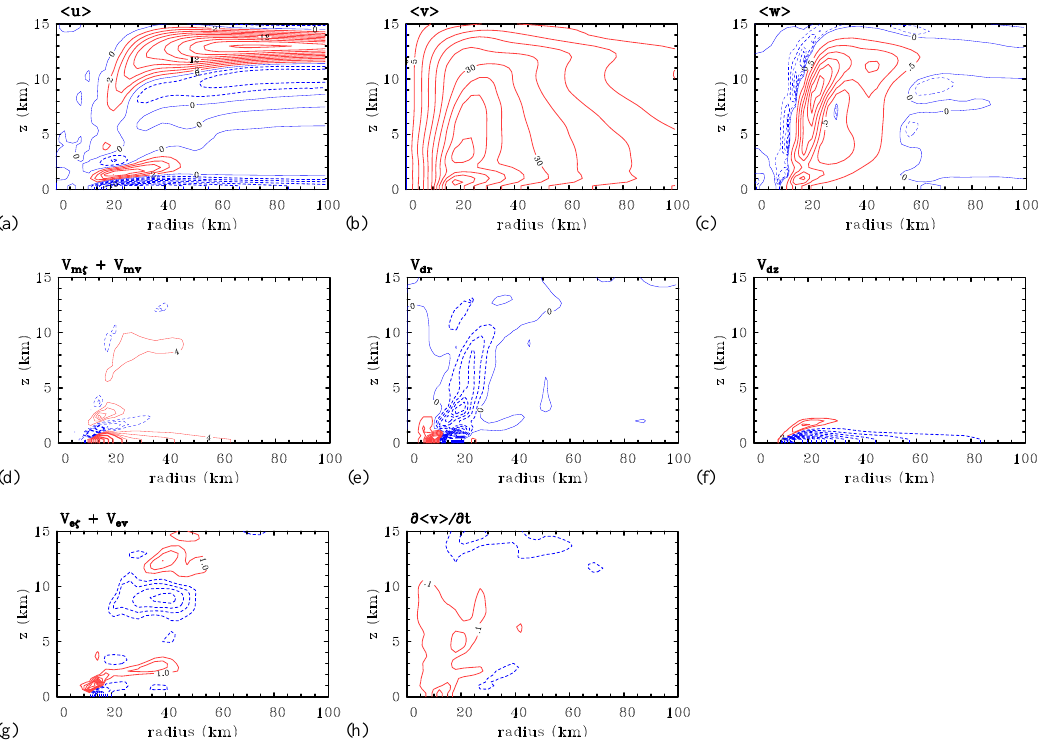
Fig. 11. Terms of the tangential wind tendency equation for the simulation 3D3k, averaged during the mature stage (214-226 h). Red contours denote positive values; blue contours denote negative values. (a) Radial velocity h u i (Contour interval 2 m s − 1 ); (b) Tangential velocity h v i (Contour interval 5 m s − 1 ); (c) Vertical velocity h w i (Contour interval for positive 0.5 m s − 1 ; negative contours -0.05, -0.1, -0.15, -0.2 m s − 1 ); (d) Sum of mean vorticity influx and vertical advection V mζ + V mv (Contour interval: thin contours 4 m s − 1 h − 1 , thick contours 20 m s − 1 h − 1 ); (e) Radial (subgrid-scale) diffusive tendency V dr (Contour interval 0.5 m s − 1 h − 1 ); (f) Vertical (subgrid-scale) diffusive tendency V dz (Contour interval 2 m s − 1 h − 1 ); (g) Combined eddy tendencies V eζ + V ev (Contour interval 2 m s − 1 h − 1 ); (h) Mean tangential wind tendency ∂ <v >/∂t (Contour interval 0.1 m s − 1 h − 1 ).